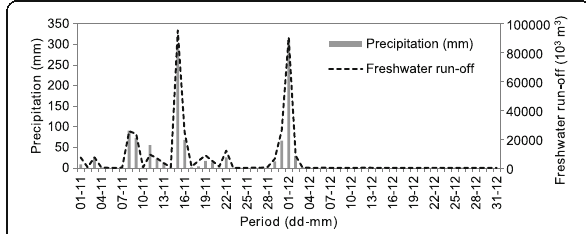
Fig. 3 Graph illustrating the amounts of daily precipitation and freshwater runoff at Pulicat drainage basin from the northeast monsoonal rainfall that caused the 2015 South India floods in